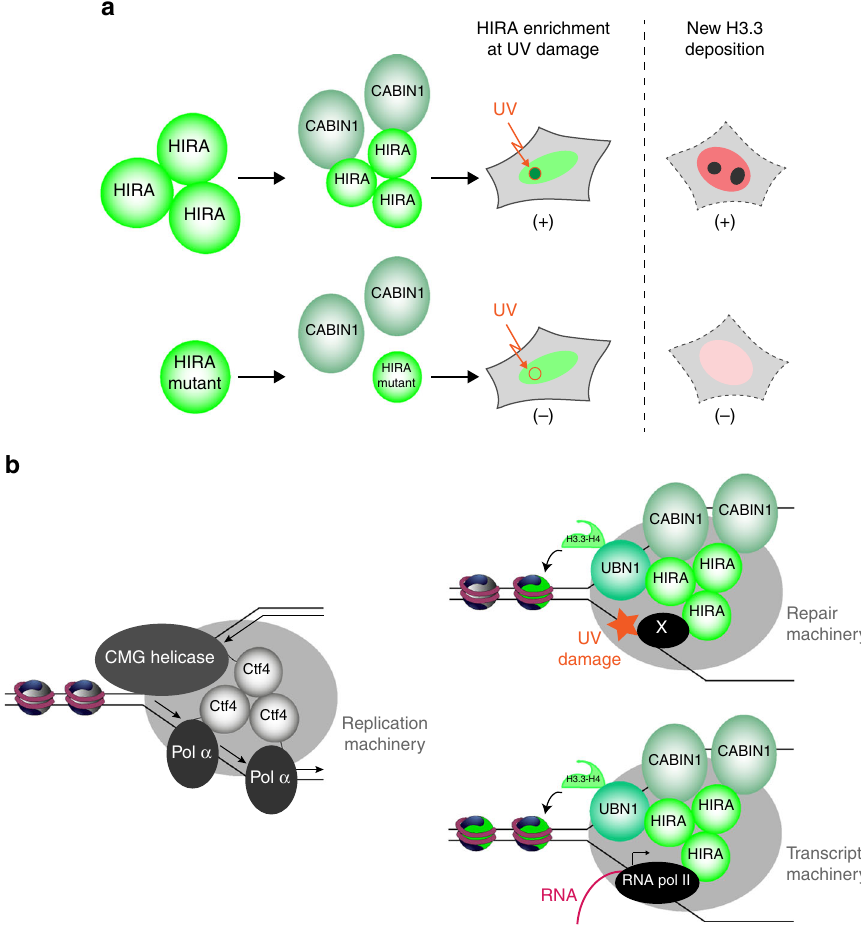
Fig. 7 HIRA homotrimerization: its role in HIRA activity and structural similarity with Ctf4/AND-1. a Scheme of HIRA homotrimerization that is required for CABIN1 interaction, HIRA enrichment at UV damage site and deposition of new H3.3 histone variant. A HIRA homotrimerization mutant cannot interact with CABIN1, is not enriched at UV damage sites and cannot deposit new H3.3. b Models for Ctf4 and HIRA homotrimers functions. (Left) Within the replisome, Ctf4 homotrimer functions as a bridge coupling two molecules of DNA polymerase α on the lagging strand to one CMG (Cdc45-MCM-GINS) helicase on the leading strand 28 . (Right) A HIRA homotrimer might act as a platform interacting with components of transcription or repair machineries in conjunction with binding to ssDNA at DNA bubble structures, allowing H3.3 deposition at these sites. HIRA may interact with RNA pol II machinery in the context of transcription as previously proposed 5 , while it may bind to a non-identi fi ed repair protein (X) in the context of DNA damage. Two CABIN1 molecules are shown, as a HIRA homotrimer was found to interact with two CABIN1 molecules in vitro (Fig. 1e). The number of UBN1 molecules associated with a HIRA homotrimer being not known, only one molecule is